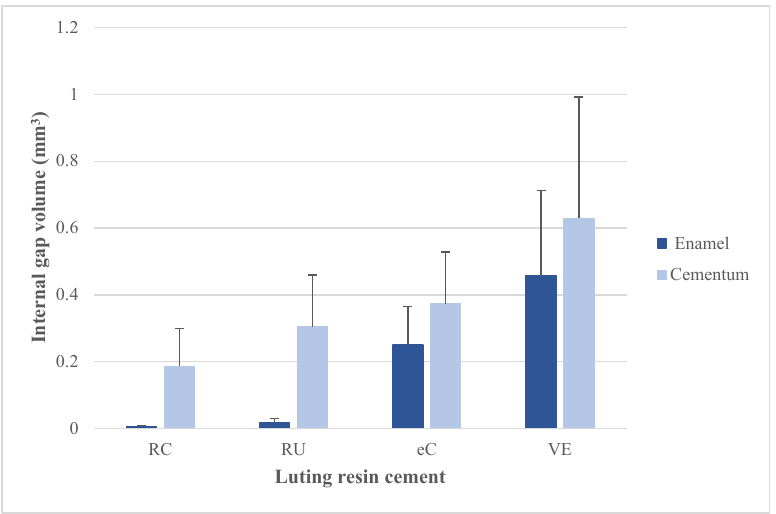
Figure 5. Mean internal gap volume (mm 3 ) of inlay restoration associated with different resin cements on enamel vs. cementum/dentin surfaces.